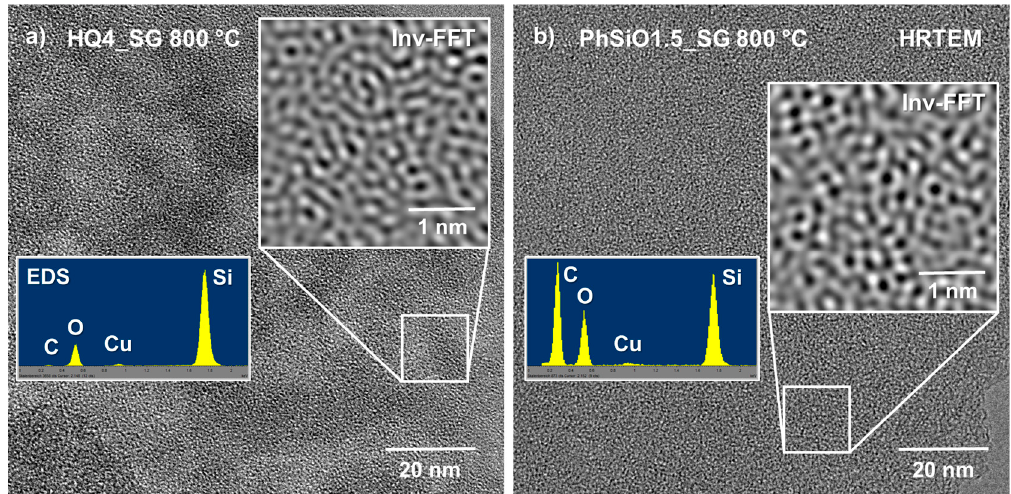
Figure 11. High-resolution transmission electron microscopy images comparing the two materials studied ( a ) HQ4_SG 800 ◦ C and ( b ) PhSiO 1.5 _SG 800 ◦ C. The Inv-FFT insets again underline the fully amorphous nature of both samples. However, a major difference found in these samples is the respective chemical composition with a much higher carbon content found in the PhSiO 1.5 _SG 800 ◦ C sample (see EDS insets), as compared to the mainly of Si and O composed material HQ4_SG 800 ◦ C. Note that the EDS results are consistent with the chemical analysis reported in Table